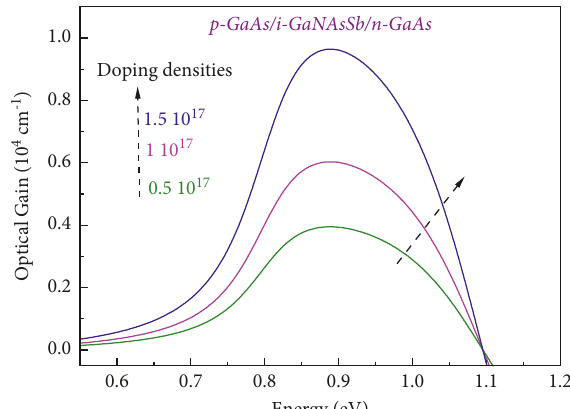
Figure 3: Optical gain as function of energy for different doping densities for p-GaAs/i-GaN with N D equal to 5 × 10 16 , 1 × 10 17 , and 1.5 × 10 17 cm − 3 . The Sb composition and well width are y Sb � 18 . 6% and L w � 4 nm, respectively.